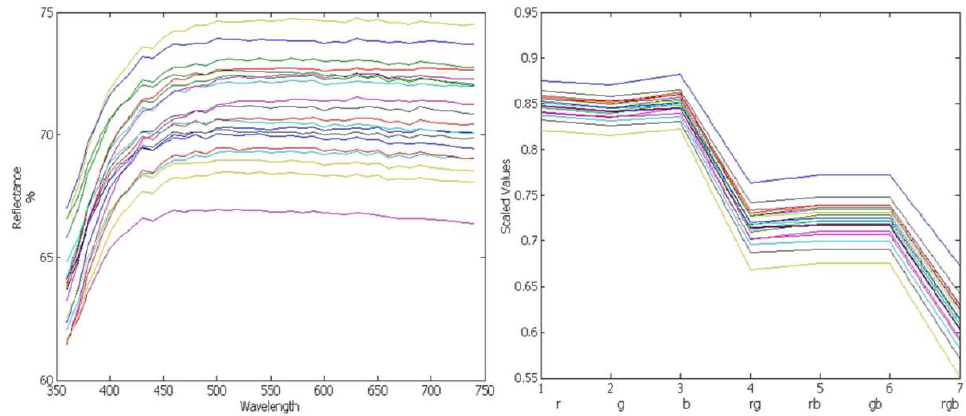
Figure 5. SCE (specular component exclusive) reflectance and r, g, b, rg, rb, gb, and rgb responses of 20 fabrics. Table 2. Fabric specifications produced from the same cotton fibers.